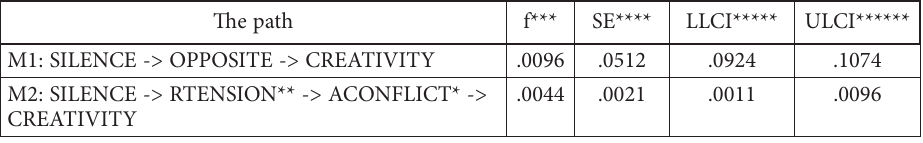
Table 5. The indirect effects (source: created by